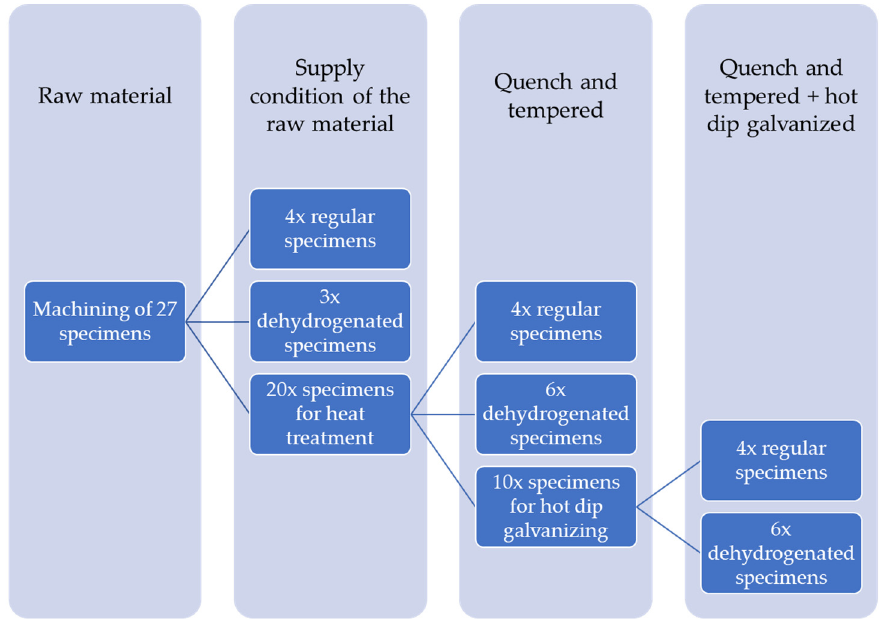
Figure 7. Materials for the study of internal hydrogenation in the manufacturing process for class 10.9 bolts.